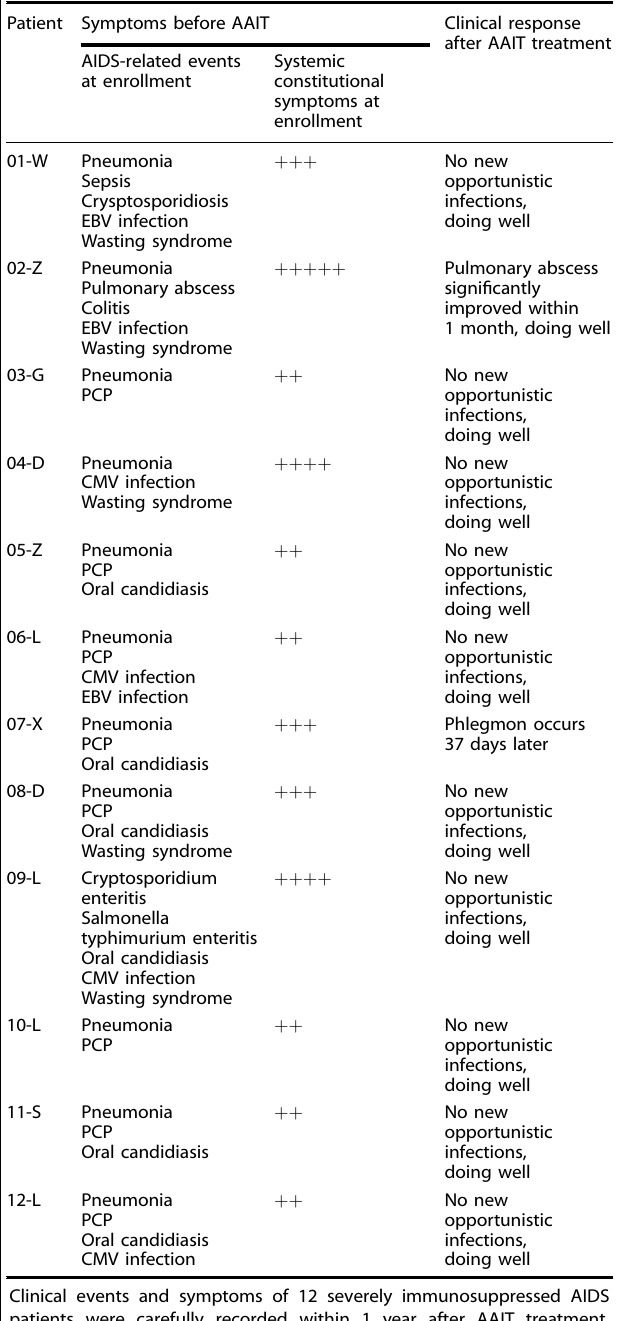
Table 2. AAIT improved clinical events and symptoms in the treated 12